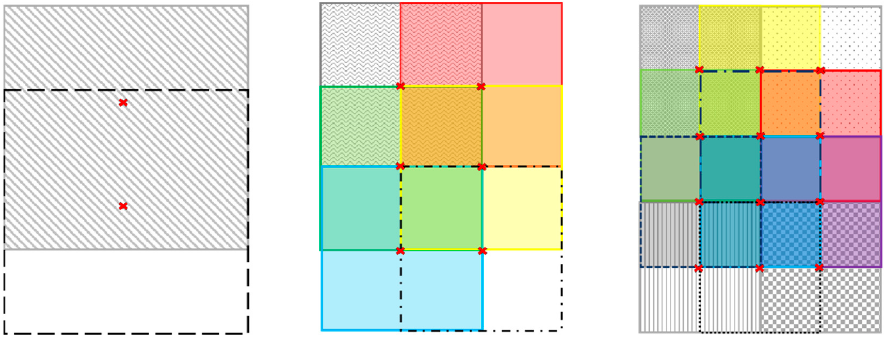
Figure 2. Illustration of RMAC regions.